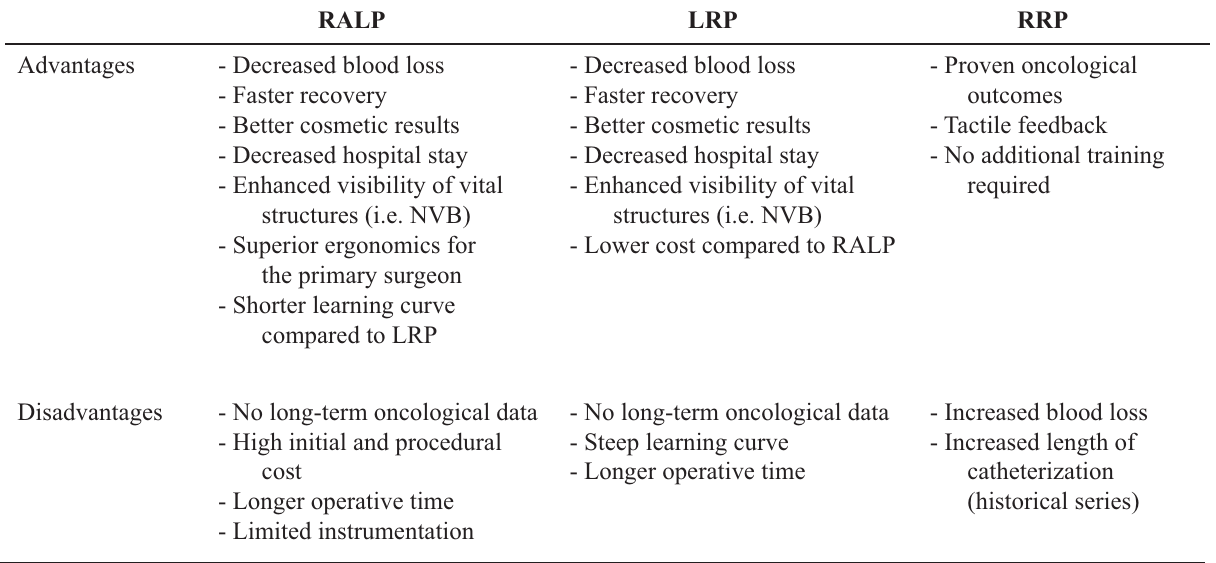
Table 3 – Advantages and disadvantages of RRP, LRP and